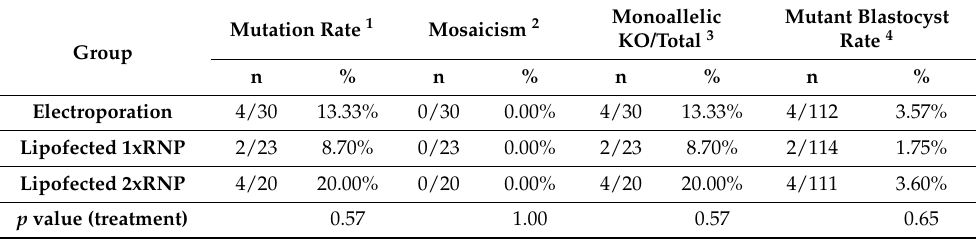
Table 6. Mutation parameters and mosaicism rate in pig embryos after electroporation or lipofection with different concentrations of the CRISPR/Cas9 system. Variables were analyzed via the non- parametrical Kruskal–Wallis test. Monoallelic Mutant Blastocyst Mutation Rate 1 Mosaicism 2 KO/Total 3 Rate 4 Group n % n % n % n % Electroporation 4/30 13.33% 0/30 0.00% 4/30 13.33% 4/112 3.57% Lipofected 1xRNP 2/23 8.70% 0/23 0.00% 2/23 8.70% 2/114 1.75% Lipofected 2xRNP 4/20 20.00% 0/20 0.00% 4/20 20.00% 4/111 3.60% p value (treatment) 0.57 1.00 0.57